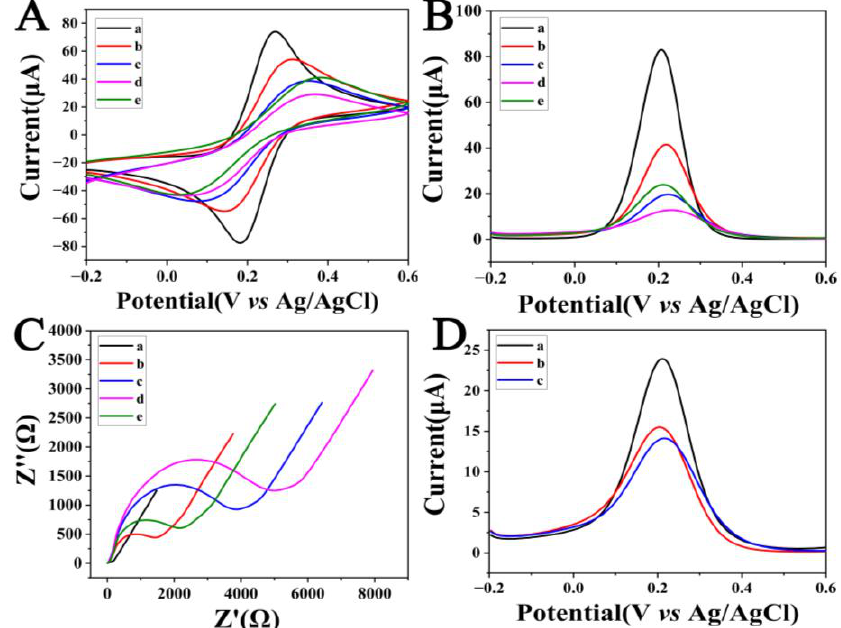
Figure 3. ( A ) Cyclic voltammograms, ( B ) differential pulse voltammetry, and ( C ) electrochemical impedance spectra of the electrode assembly process. Bare MGCE (a), Fe 3 O 4 -NH 2 -Apt1/MGCE (b), exosomes/Fe 3 O 4 -NH 2 -Apt1/MGCE (c), Apt2/exosomes/Fe 3 O 4 -NH 2 -Apt1/MGCE (d), and MXene-Gly- Apt2/exosomes/Fe 3 O 4 -NH 2 -Apt1/MGCE (e) in 5 mM [Fe(CN) 6 ] 3-/4- containing 0.1 M KCl solution. The scan rate was 100 mV s −1 . The impedance spectra were recorded from 0.1 Hz to 100 kHz with a signal amplitude of 5 mV at the formal potential of the redox couple. The concentration of exosomes was 10 4 particles μL −1 . ( D ) DPV current comparison of MXene-Gly-Apt2/exosomes/Fe 3 O 4 -NH 2 -Apt1/MGCE (a), MXene-Gly-Apt2/exosomes/Apt1/MGCE (b), and Gly-Apt2/exosomes/Fe 3 O 4 -NH 2 -Apt1/MGCE (c). The concentration of exosomes was 10 4 particles μL −1 .